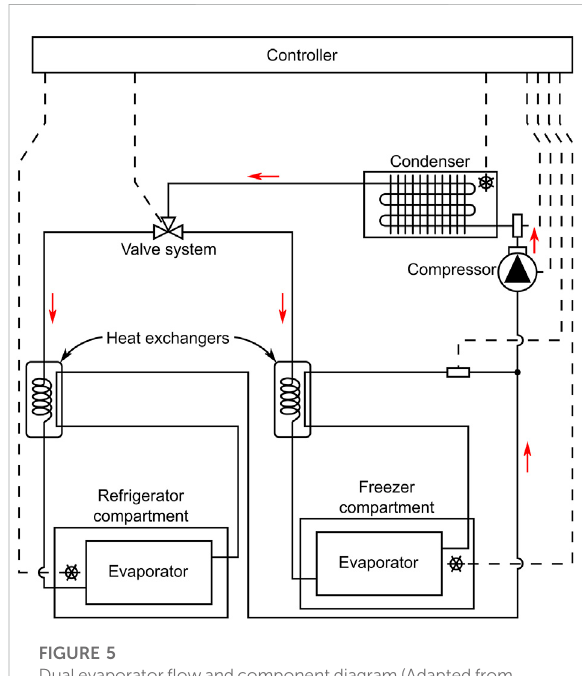
FIGURE 5 Dualevaporator fl owandcomponentdiagram(Adaptedfrom US Patent